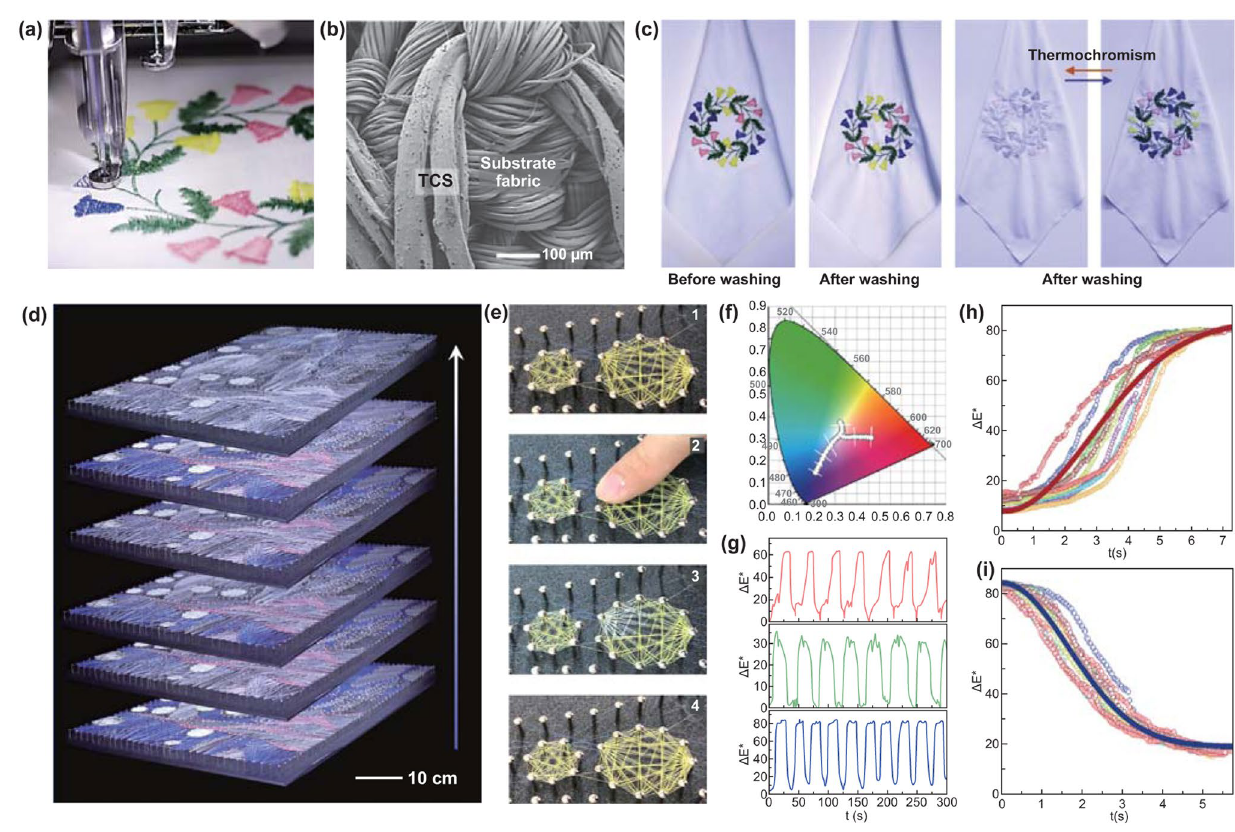
Fig. 3 Washability and programmable thermochromism of TCSs. a Photograph of an automatic embroidery machine kintting the TCS yarns to a subtle logo pattern. b SEM image of the TCS yarns on the substrate fabric after machine washing. c Photographs of textile embroidery with color-changing pattern composed of TCS yarns before washing and after washing. d Photographs of color-changing TCS weaving pattern when the heat source passed from left to right. e Photographs of color-changing TCS weaving pattern approached by fingers. f Themochromic channel of red, green and blue TCS shown in CIE 1931 chromaticity diagram. g The variation of total color difference Δ E* of red, green and blue TCS with the temperature change controlled by the hot and cold circulating water. h , i Fitting plot of the variation of Δ E* when temperature rises ( h ) and drops ( i